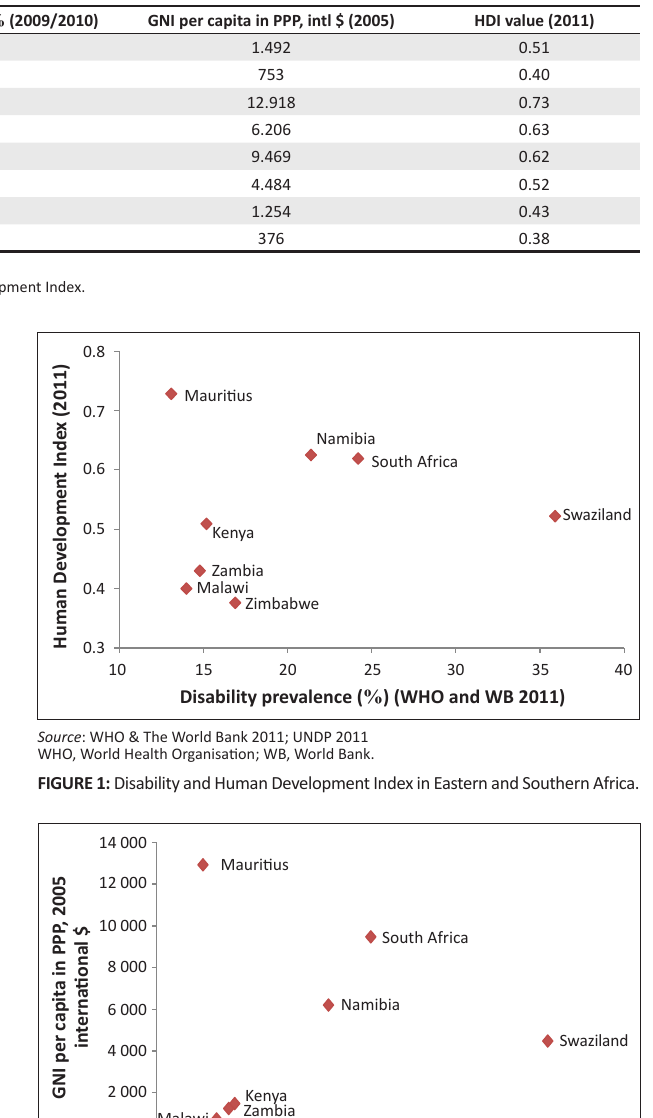
TABLE 1: Socio-economic, disability and HIV data for Eastern and Southern Africa. Countries Disability prevalence, % (2010/2011) HIV-prevalence, % (2009/2010)